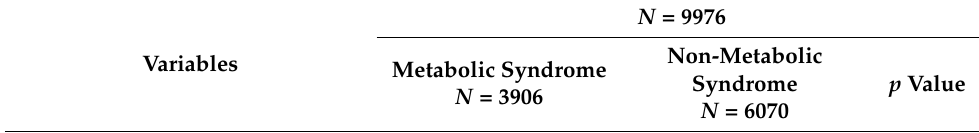
Table 1. Characteristics of participants with and without metabolic